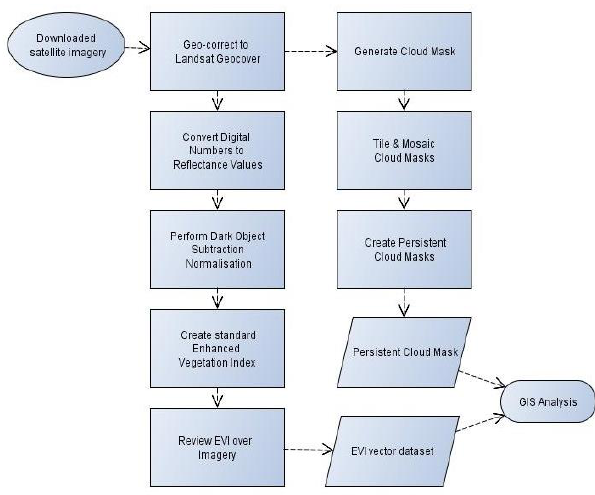
Figure 3: Image processing flow diagram © The Guyana Forestry Commission and Indufor